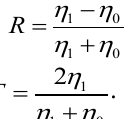
Figure 1: Geometry of the buried PEMC cylinder. The cylinder is located in an isorefractive lower half-space at a distance d from an interface separating the two isorefractive half-spaces, and is excited by a line source located in the upper